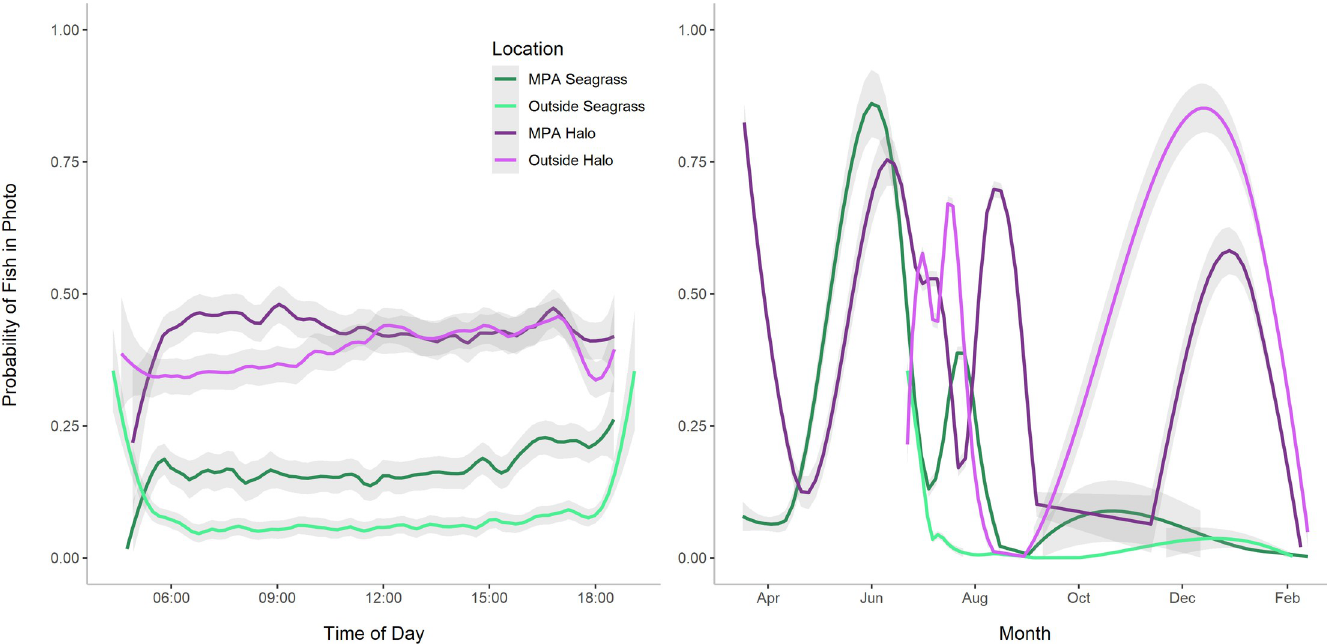
Fig 7. Time series showing smoothed data from 40 different cameras deployed asynchronously between March 2018 and March 2019. (A) Fish probabilities for individual images in halo/reef and seagrass/algae habitats by time of day. Probabilities ranged from 0 to 1 for this dataset, but smoothing visually compresses the highest and lowest probability values on the graph. (B) Fish probabilities for images by date, showing variation over the course of one year at Lighthouse Reef Atoll. Trend lines for all groups were generated using the geom_smooth function with method “loess” in ggplot2 [53]. Light gray shading represents 95% confidence intervals.